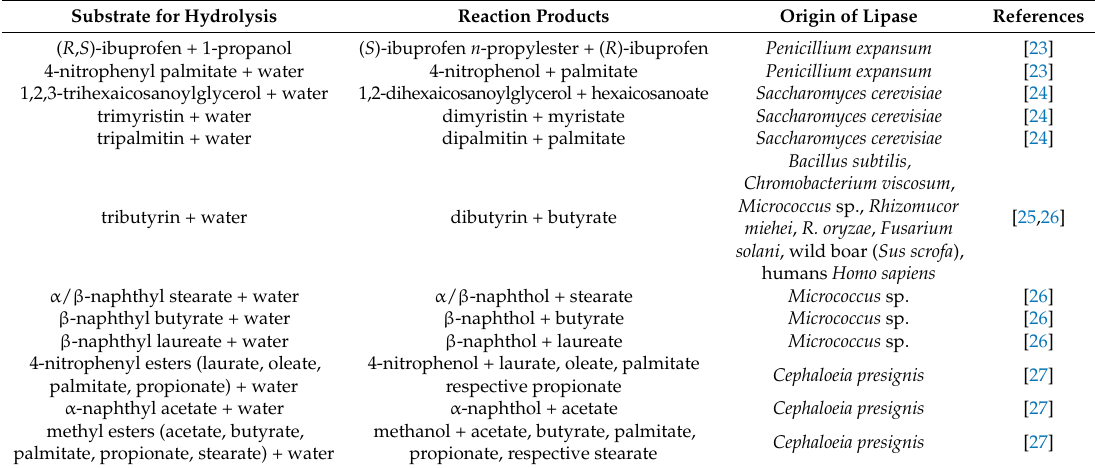
Table 1. The survey of substrates and products in reactions catalyzed by lipases E.C. 3.1.1.3. Substrate for Hydrolysis Reaction